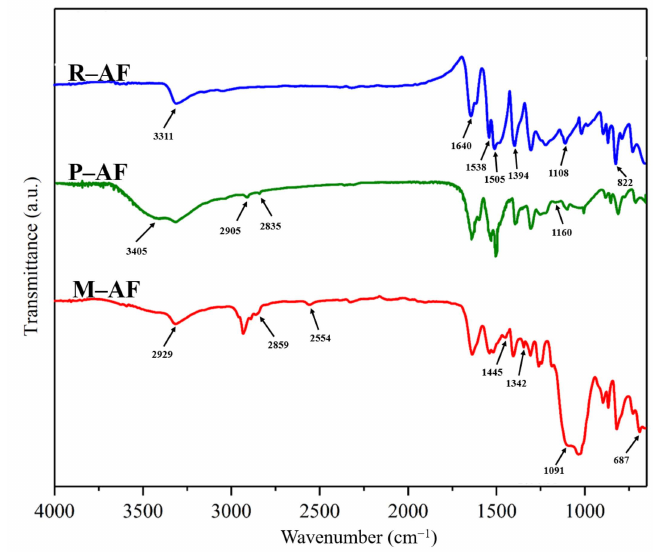
Figure 8. FTIR spectra of R-AF, P-AF, and